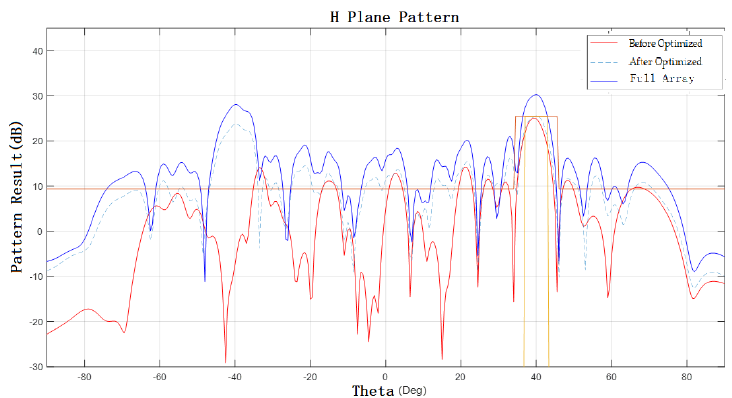
Figure 11. H-plane orientation of the array after optimization of the subarray amplitude–phase distribution at 40-degree scan angle.